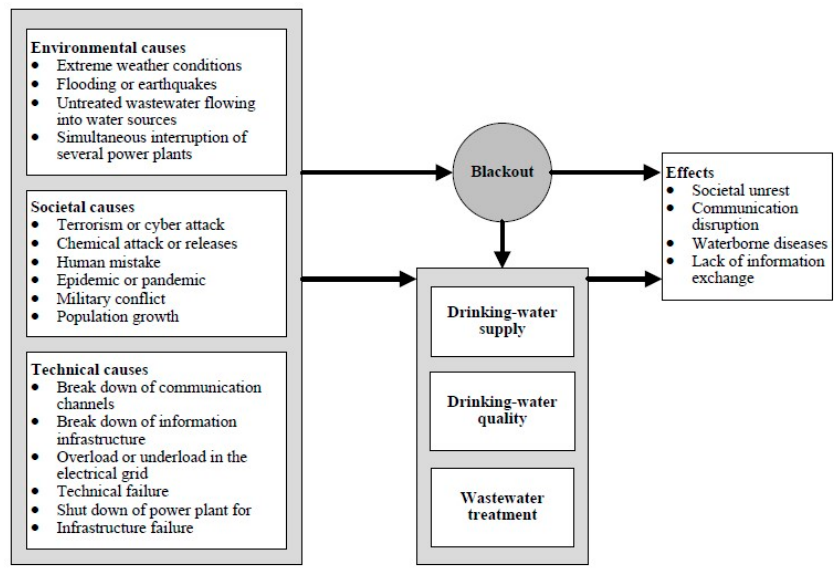
Figure 2. Diagram of the possible causes, hazard and effects [4].